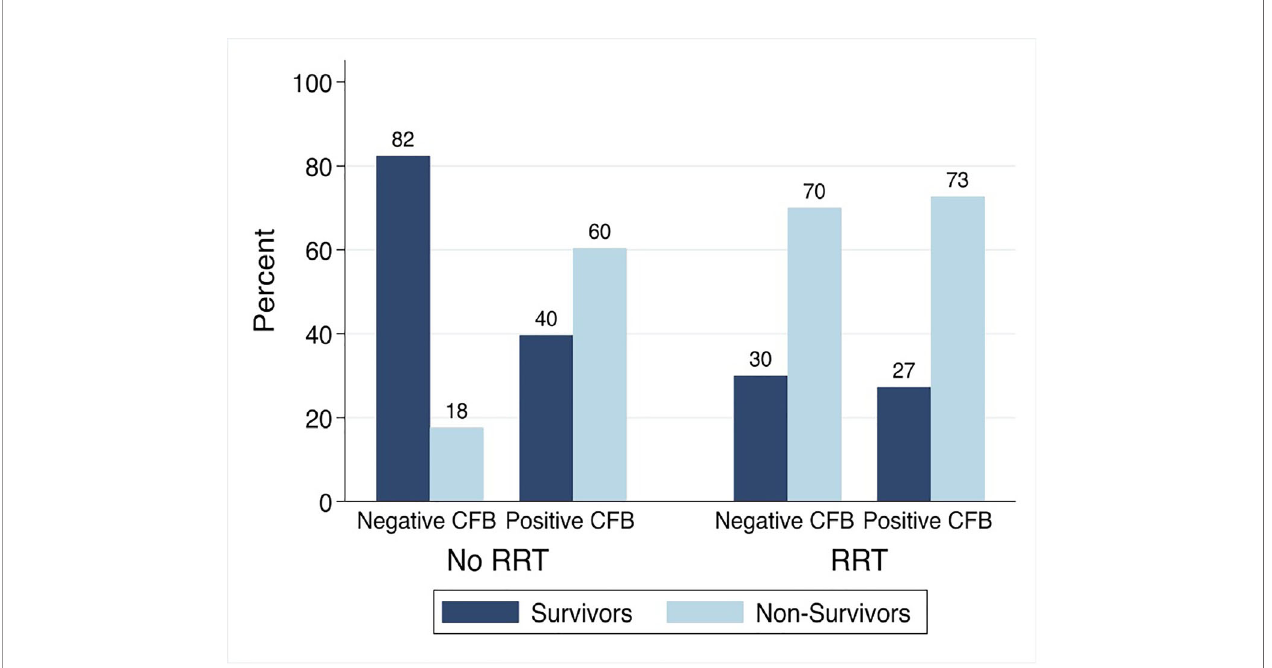
FIGURE 6 | PICU Mortality by Day 3 Cumulative Fluid Balance Strati fi ed by Treatment with Renal Replacement Therapy. CFB, cumulative fl uid balance; RRT, renal replacement therapy; Non-Survivors, Patients with PICU